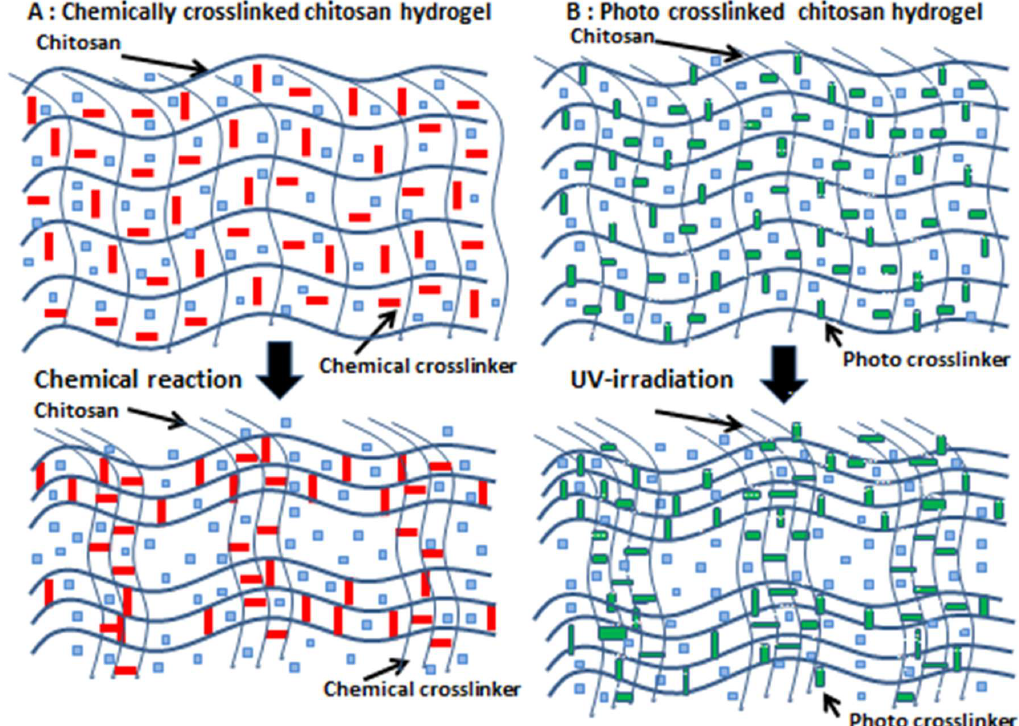
Figure 1. Simplified schemes of gelling mechanisms. ( A ): Chemical crosslinking gelation due to chemical reactions between crosslinkers and polymers. ( B ): Photocrosslinking due to radical reactions between photocrosslinkers and polymers.